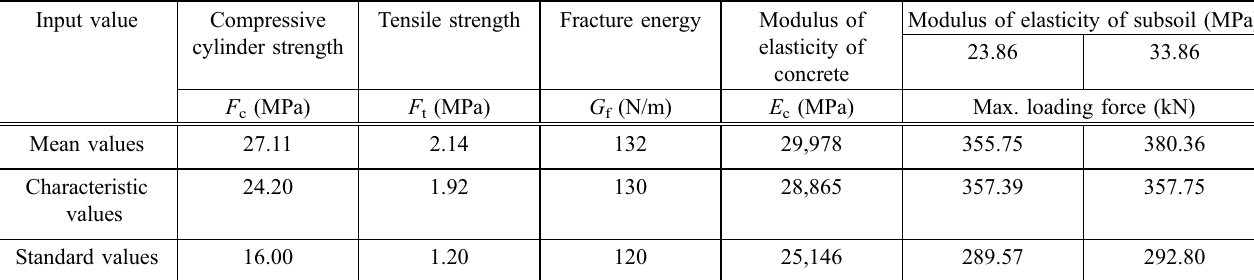
Table 4 Maximum force in press according to the used value of strength with the nonlinear analysis.